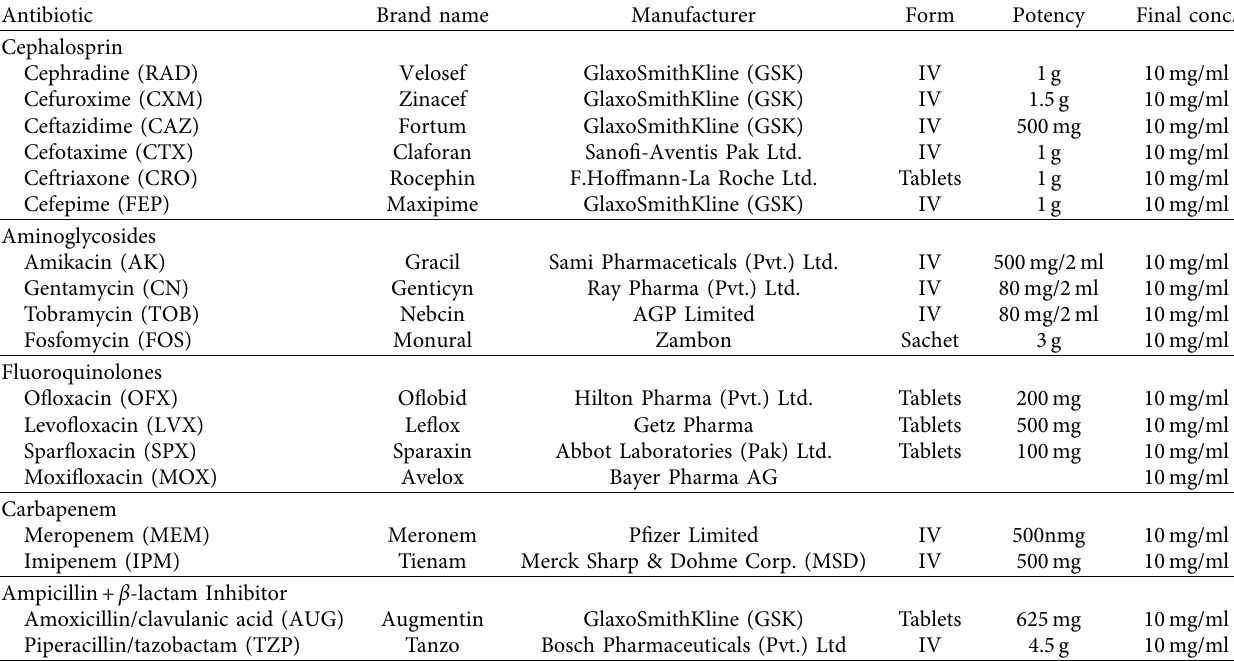
Table 1: List of antibiotics tested against the MRSA isolate